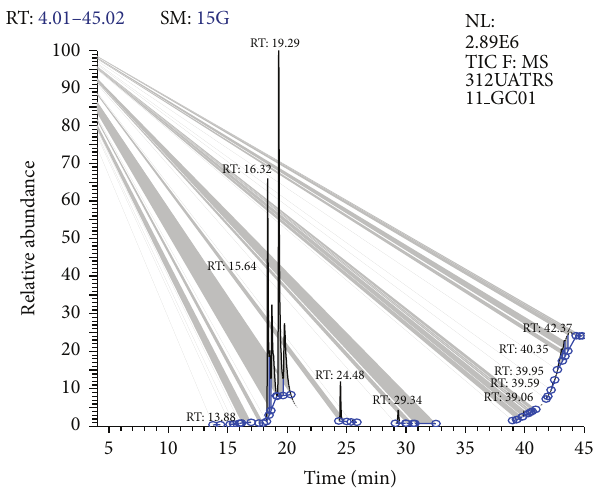
Figure 1: Gas chromatography-mass spectrometry (GC-MS) of Melissa officinalis L. essential